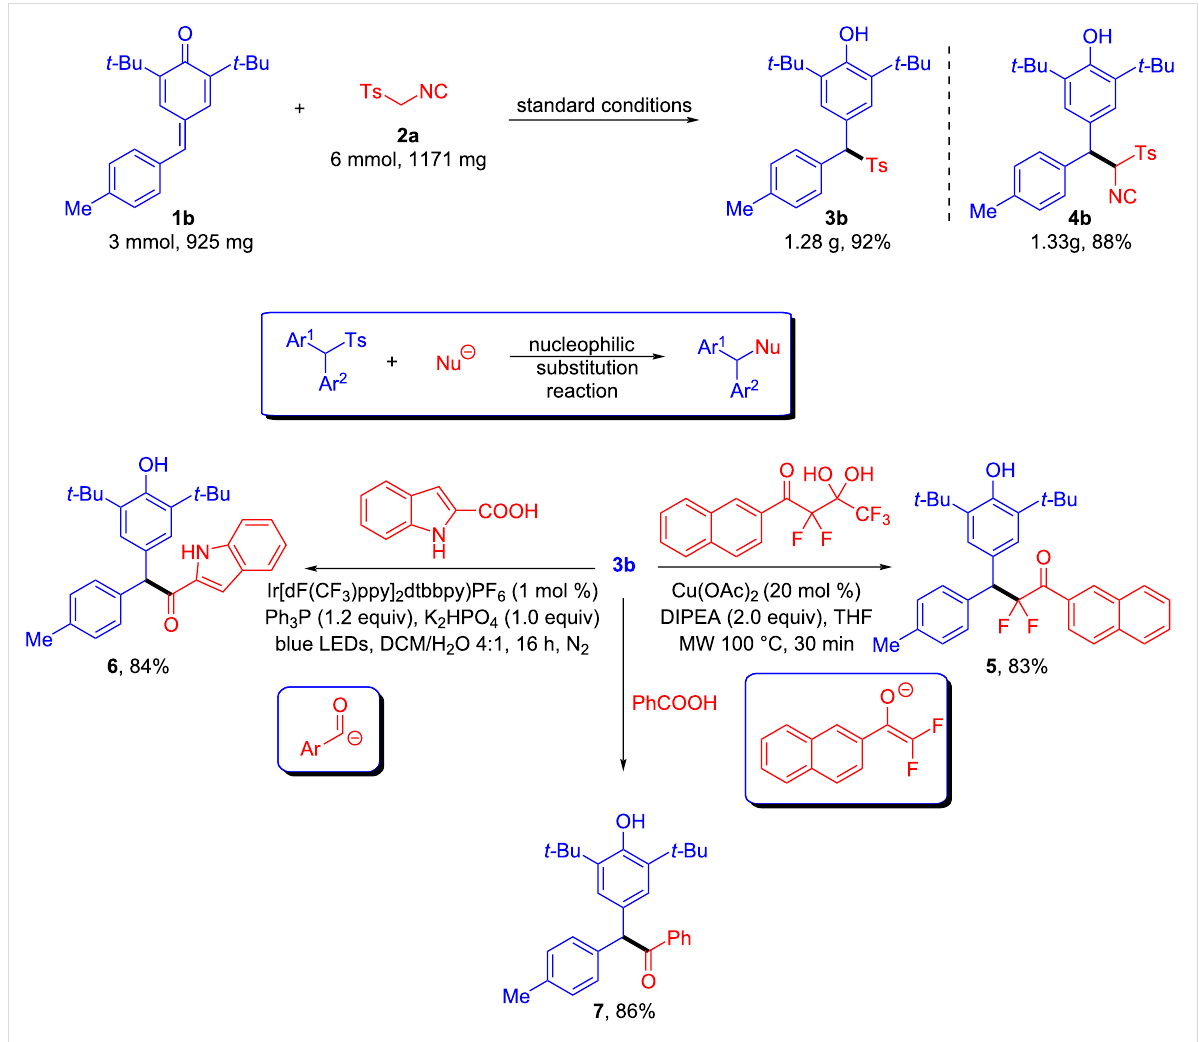
Scheme 5: Synthetic applications of the synthesized compound 3b